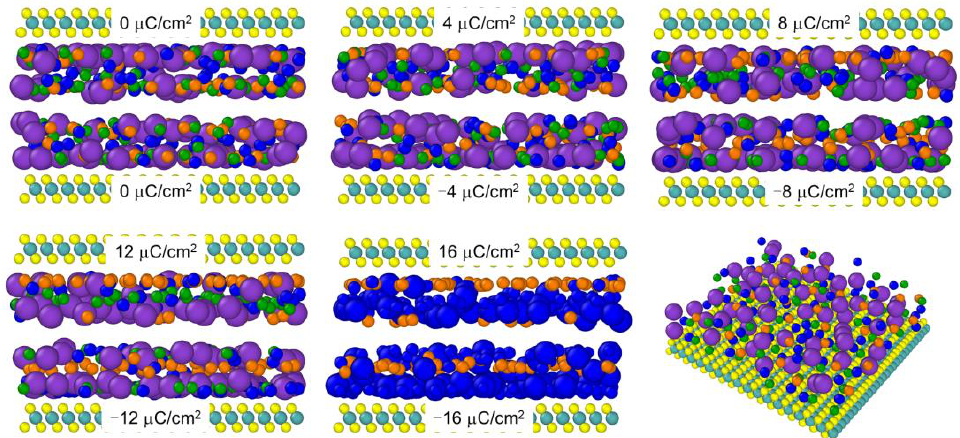
Figure 3. Representative MD simulation snapshot of [BMI + ][PF 6 − ] electrolyte on the MoS 2 electrodes. Green and yellow colors denote the electrode of the Mo atom and S atom, respectively. Purple and lemon-yellow colors present the electrolyte of cation and anion, respectively.